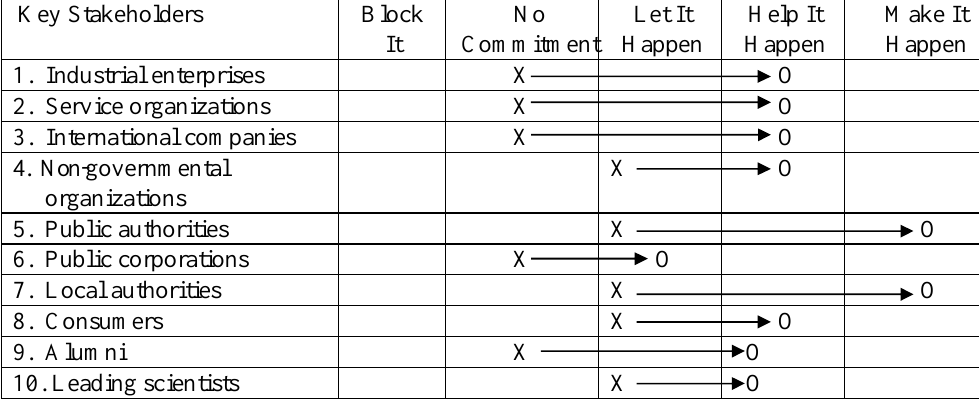
Table 1 – Partnership Commitment Chart of Key Stakeholders of University Key